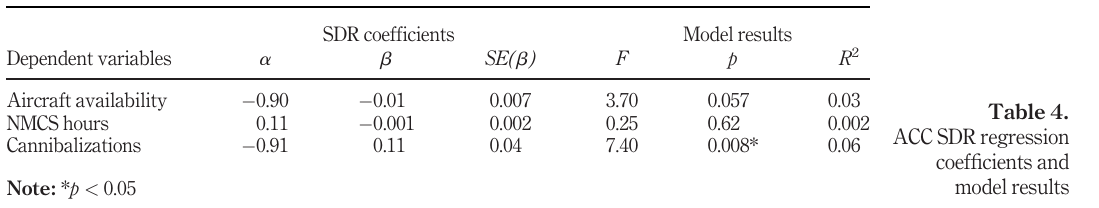
Figure 6. ACC Cann residual plot